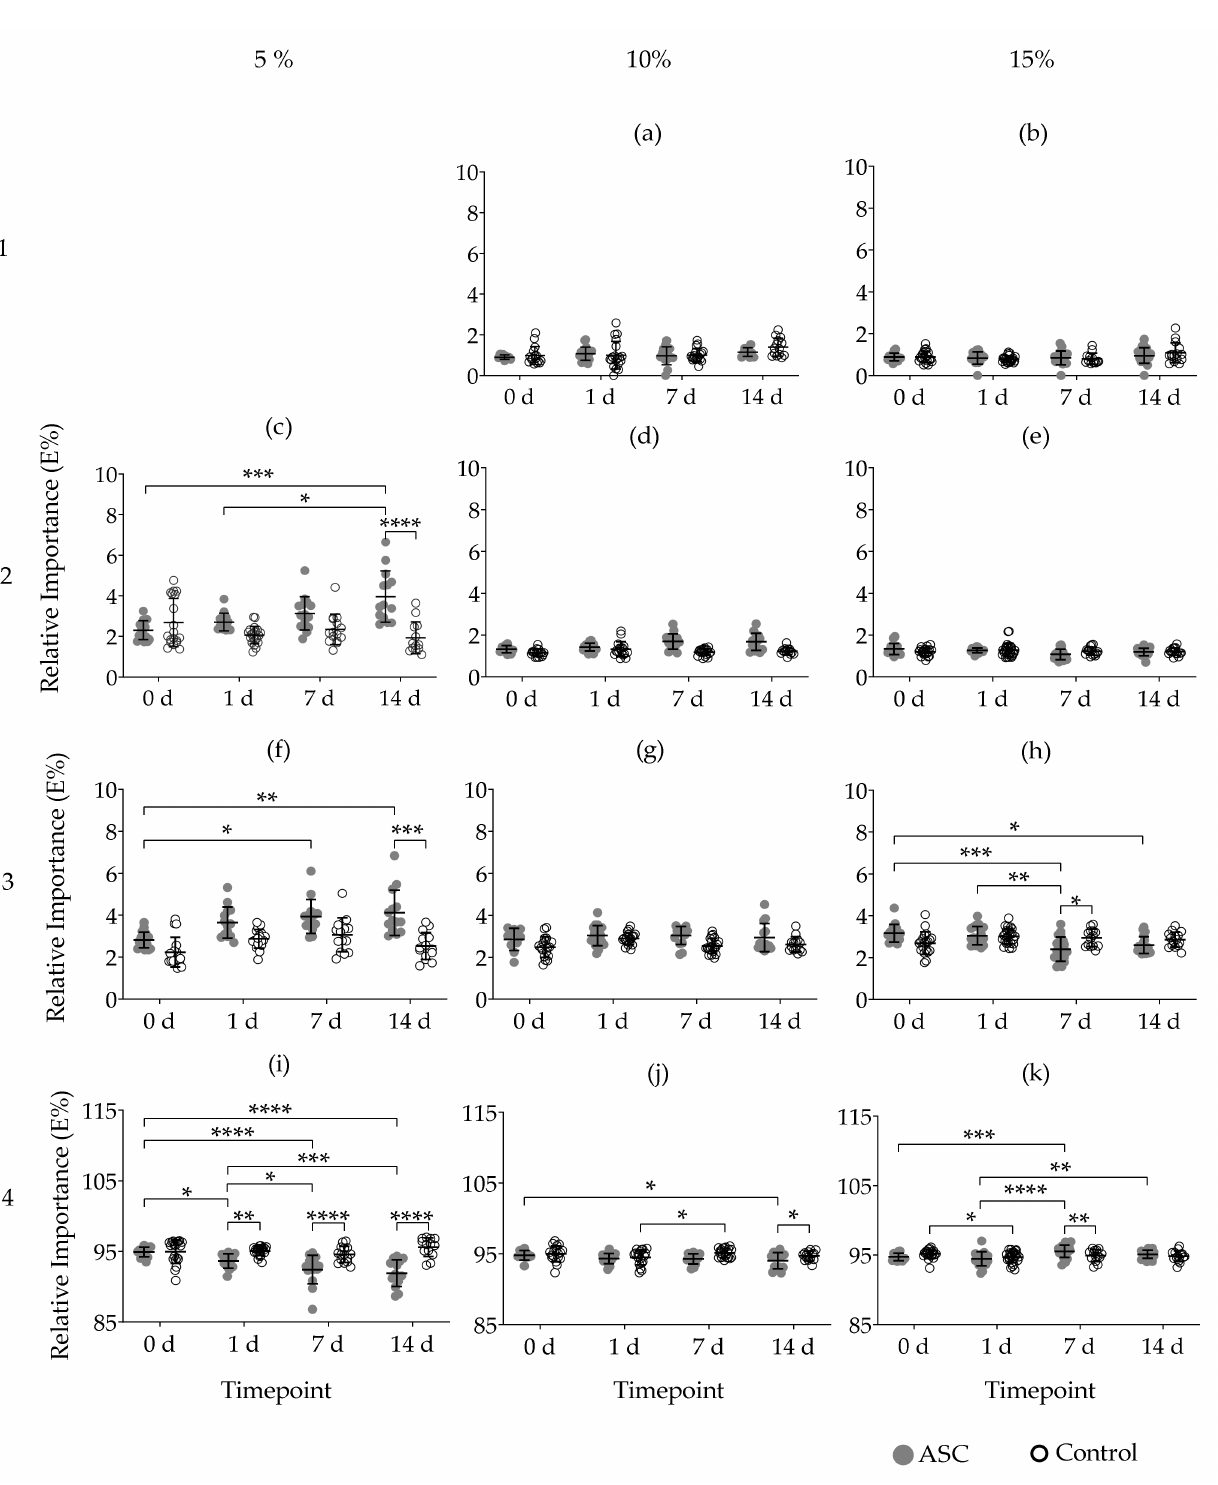
Figure 4. Relative importance of each Maxwell element of cell-loaded (ASC) and cell-free (Control) GelMA hydrogels after 14 days in culture. Fitting GelMA stress relaxation data into a generalised Maxwell model determined the number of Maxwell elements 1 ( τ ≤ 1 s), 2 (1 < τ ≤ 10 s), 3 (10 < τ ≤ 100 s), and 4 ( τ > 100 s) as well as the contribution of each element (relative importance or R i ) to the stress relaxation process ( a – k ). Changes in R i of each Maxwell element in 5% ( c , f , i ), 10% ( a , d , g , j ), and 15% GelMA ( b , e , h , k ) are shown. Data derives from a minimum of five non-paired samples per timepoint, from three independent experiments. Data are presented as mean with standard deviation. p values are indicated * p < 0.05, ** p < 0.01, *** p < 0.001 and **** p < 0.0001 according to Two-way ANOVA and